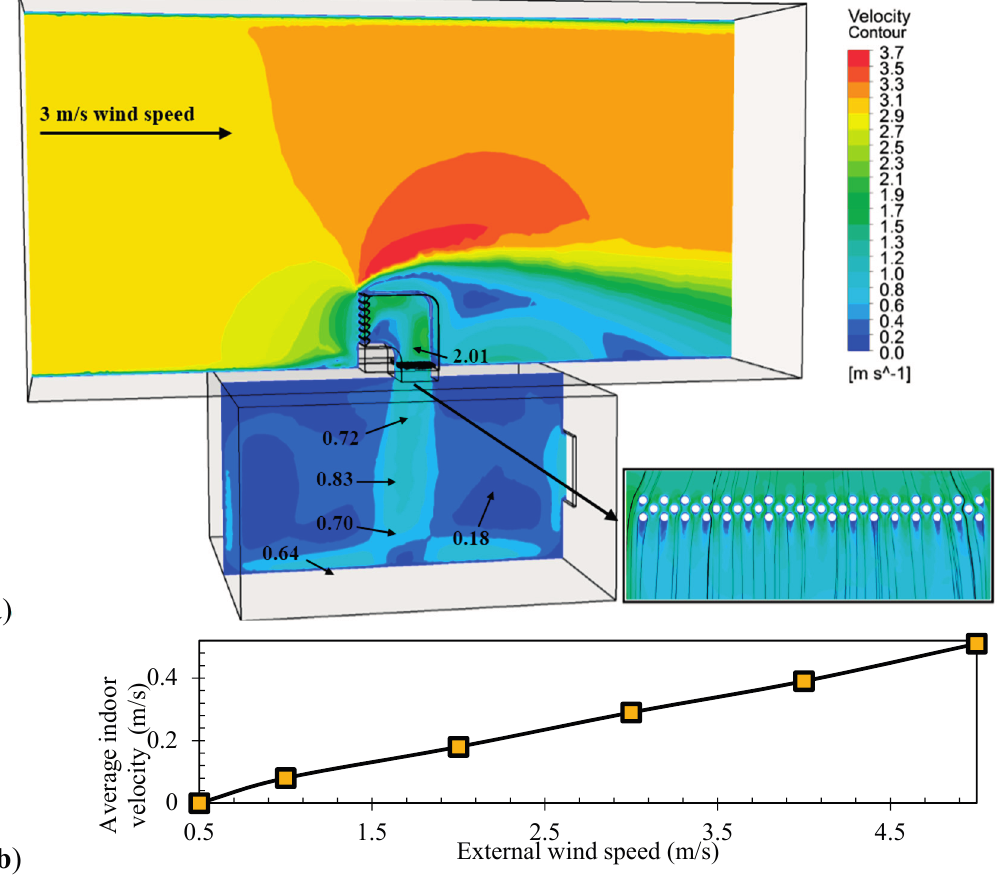
Figure 15. ( a ) Velocity contour plot of a cross-sectional plane; ( b ) Effect of variation of external wind speed on average indoor airflow